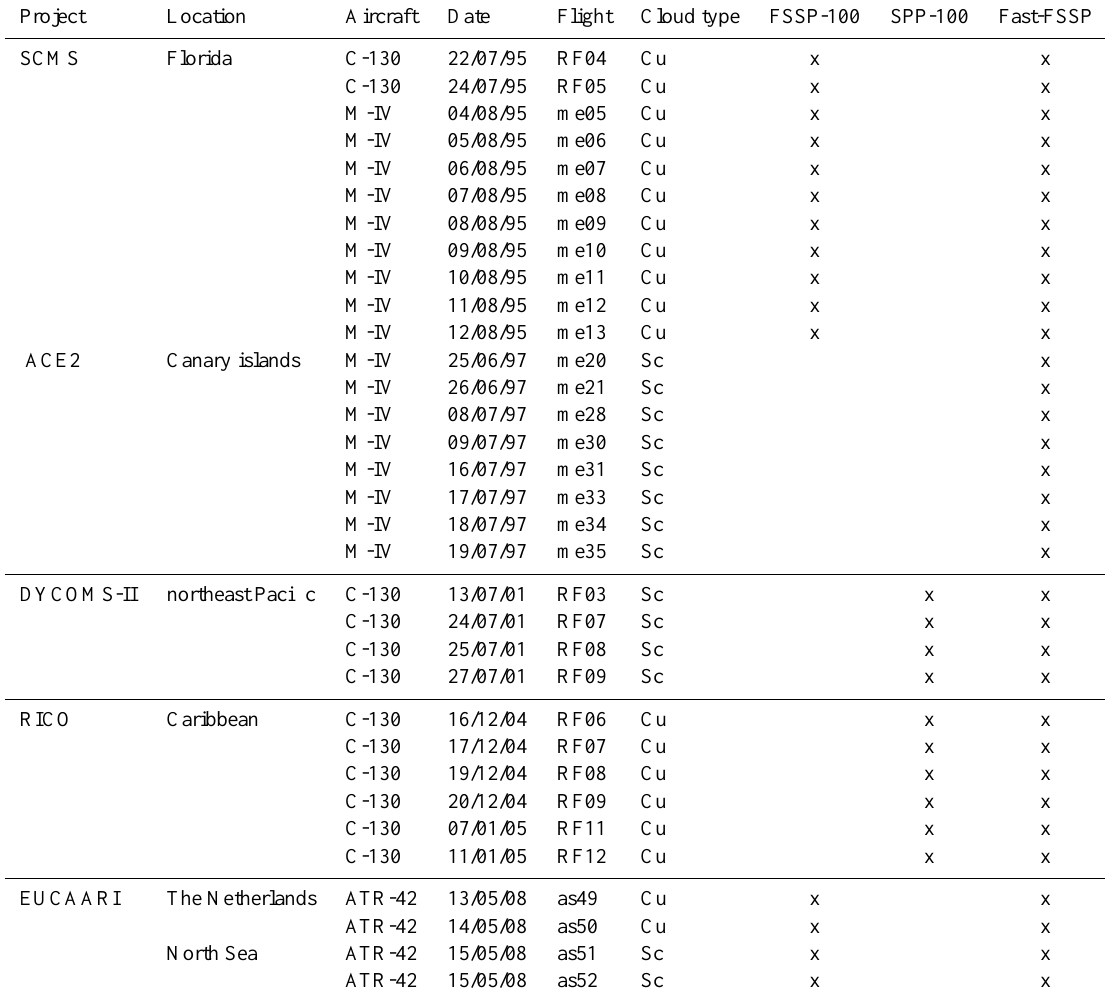
Table 1. List of flights analysed here with the project name, the campaign location, the aircraft used, the type of sampled clouds and the FSSP versions that were operated.